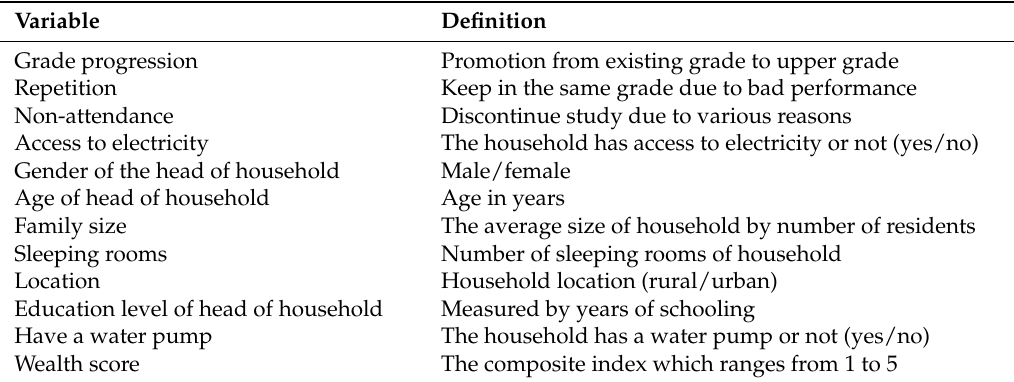
Table 1. Variable definitions.